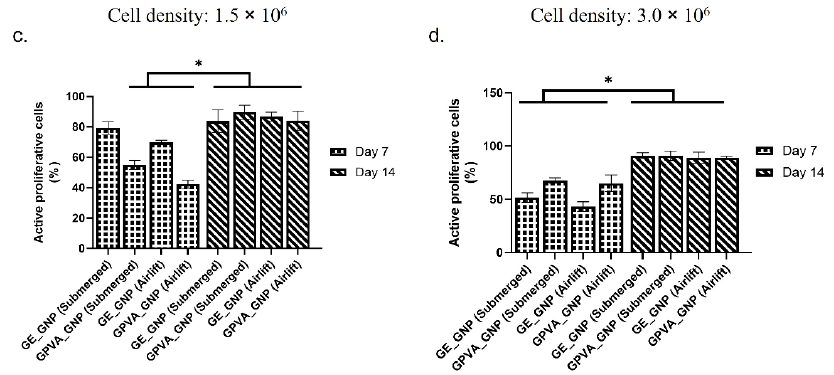
Figure 6. Fluorescence images of ki67 stained HDFs encapsulated in the hydrogels under different cell densities and cultivation models. ( a ) With 1.5 × 10 6 of cell density. ( b ) With 3.0 × 10 6 of cell density. The HDFs were stained for active proliferative nucleus (red; Ki67), and nucleus (blue; DAPI) under 20× magnification. ( c ) Percentage of active proliferative nucleus of HDFs for 1.5 × 10 6 of cell density. ( d ) Percentage of active proliferative nucleus of HDFs for 3.0 × 10 6 of cell density. * indicates p < 0.05.